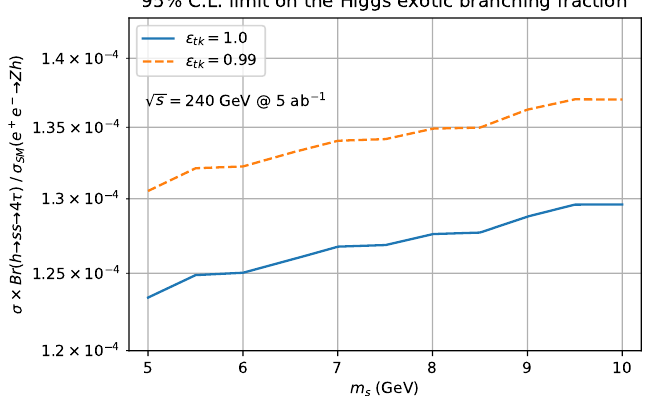
Figure 13. Bounds on decay of the SM Higgs boson into two light scalars, with a 4 τ final state, at an e + e − collider with a com energy of 240 GeV, with different assumptions on tracking efficiencies. Taken from [43].